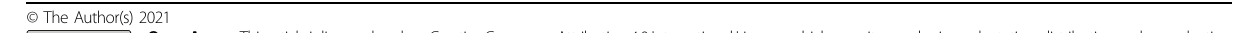
The original version of this article unfortunately con- tained an error in Figure 4. The H&E stained picture in the HOPE group in Figure 4 was wrong. The authors apologize for the error. The correct Figure 4 can be